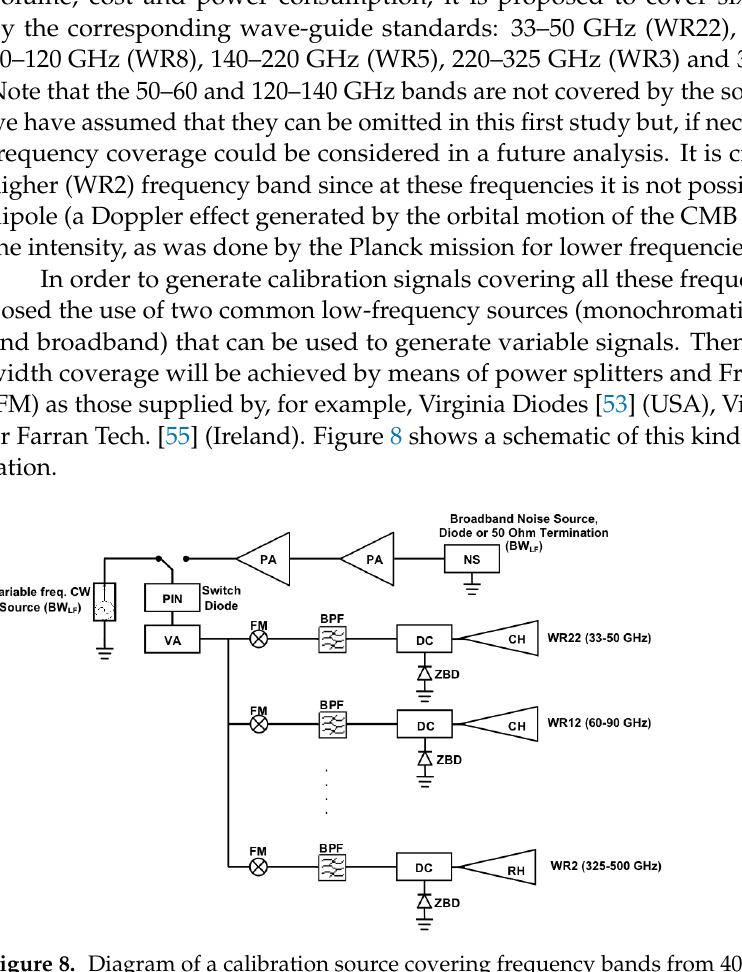
Figure 8. Diagram of a calibration source covering frequency bands from 40 to 400